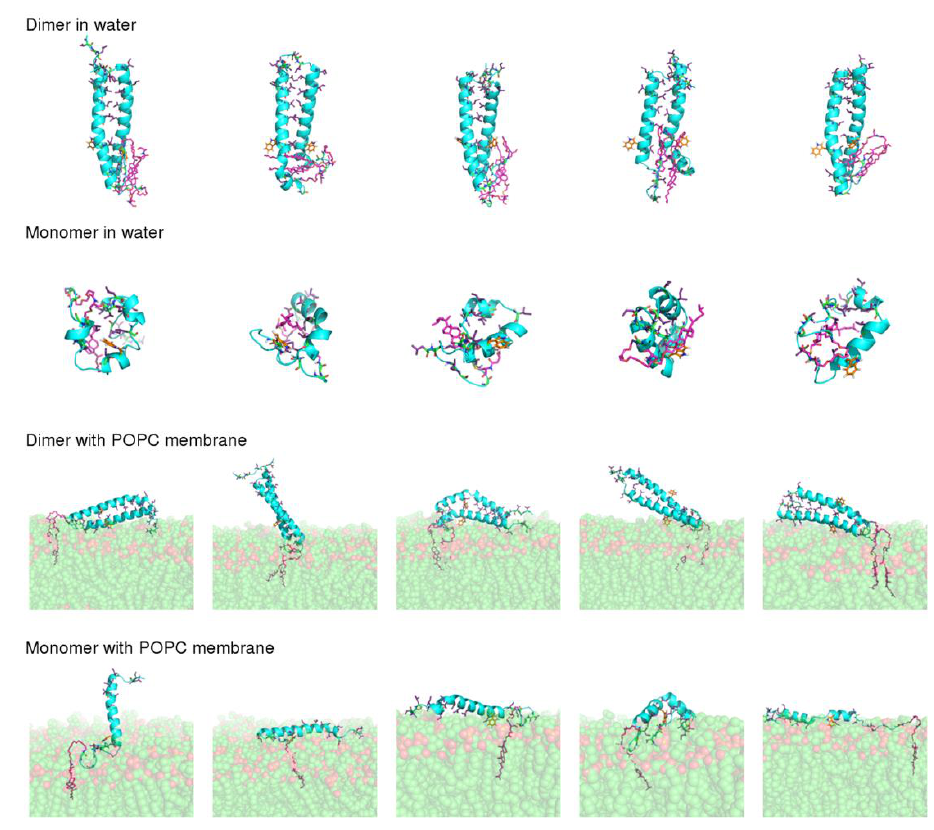
Figure 5. Final conformations of the VIKI-dPEG 4 -Chol peptide after 100 ns of MD simulation. Simulations of the dimeric and monomeric forms of the peptide in water and in the presence of a POPC membrane were performed and each row corresponds to a different simulation set, as indicated in the label. The five structures displayed for each simulation set correspond to independent replicates, with replicates 1 to 5 ordered from left to right. The secondary structure of the VIKI peptide is represented by a cyan cartoon model, the PEG-Chol tail is shown using magenta sticks and the Trp residue is displayed using orange sticks. The hydrophobic residues of the peptide are highlighted using purple sticks and the atoms of the POPC lipids are represented by spheres with the carbon atoms colored in green.